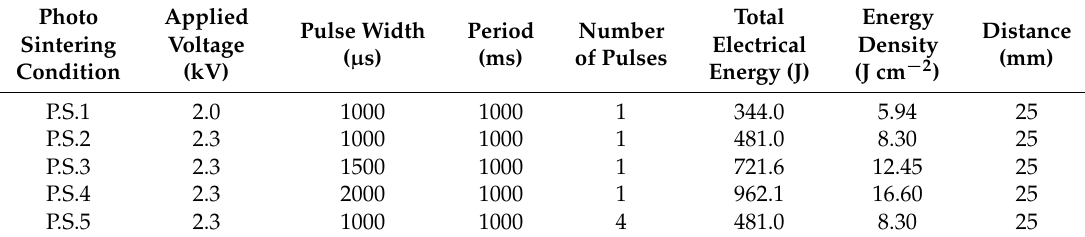
Table 4. Intense pulsed light sintering conditions.